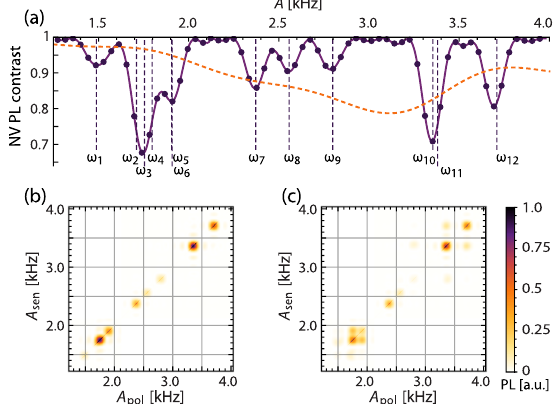
FIG. 4. Simulated 1D and 2D NMR spectra for the binding site in CXCR4, obtained with the NV-based filtered sensing protocol. (a) Simulated normalized spin-dependent NV photoluminescence (PL) after the filtered cross-polarization sequence. The x axis shows the on-resonance dipolar frequency A at each measurement ffiffiffi p 3 þ ω point, while the driving frequency is Ω ¼ A= 2 = (with L ¼ 2 MHz) and the gradient time t ¼ Larmor frequency ω ffiffiffi p L g 2 π = ð A= 3 þ ω Þ . A homonuclear decoupling sequence was L applied to the 13 C spins to narrow their intrinsic linewidth. The PL shows dips when A and the inverse gradient time (simultaneously swept) match the longitudinal dipolar coupling A j of one nuclear 13 C spin in the protein. We simulated the 12 13 C spins in the ARG and ILE active site and a NV center 1.75 nm below the diamond surface, with the [111] axis aligned around the vertical direction. The gradient time was varied from 201.68 ≈ 6 ms to 201 . 84 μ s (for a maximum total gradient time of T g in F ¼ 30 steps). The total polarization time was t ¼ 720 μ s. The dip height is a measure of the transverse dipolar coupling B j ⊥ . The spectrum shows eight dips, with the height indicating overlapping contributions from almost equivalent spins. The dashed line is the spectrum one would obtain with a DD-based protocol distorted by the spin-spin couplings (Ref. [34]). (b) Simulated 2D NMR spectra from the proposed protocol. After polarization (obtained with the same parameters as for the ¼ 300 μ s, 1D spectrum), the nuclear spins evolve freely for t d allowing polarization diffusion. The polarization is then mapped back to the NV center and measured via its spin-dependent PL. The left plot is the 2D NMR spectrum for no diffusion ¼ 0 , while the right plot shows the spreading of polarization t d in the nuclear spin network, as indicated from off-diagonal nonzero